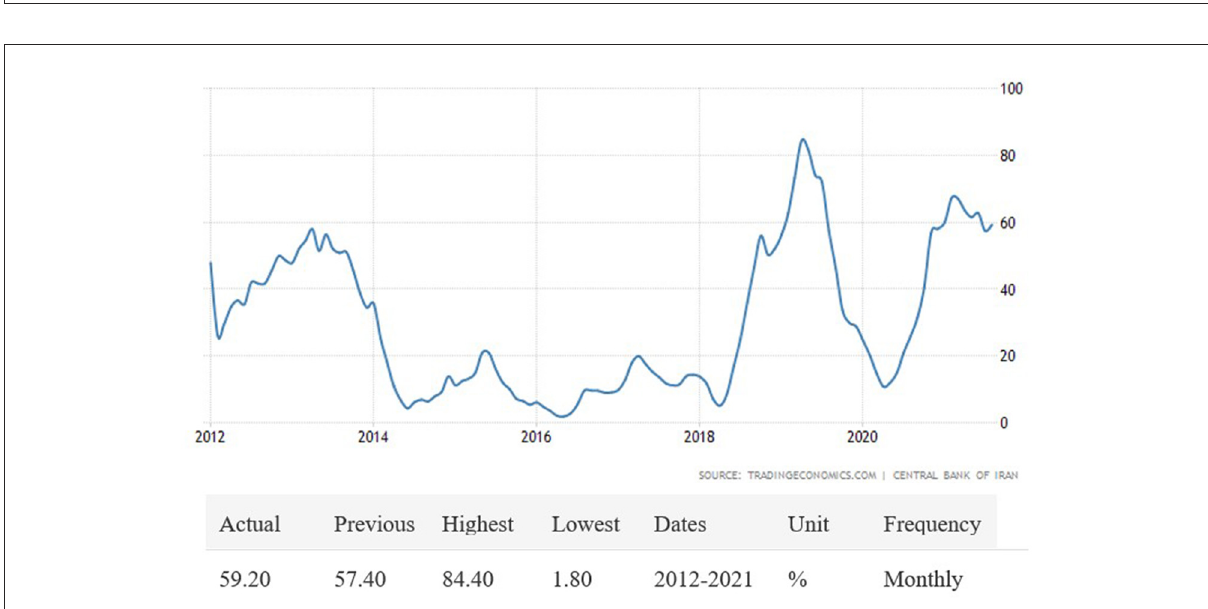
FIGURE2 Monthly percentage of food inflation in Iran 2012–2021, with 2011 as the base year to calculate inflation rate (Source: Central Bank of Iran,